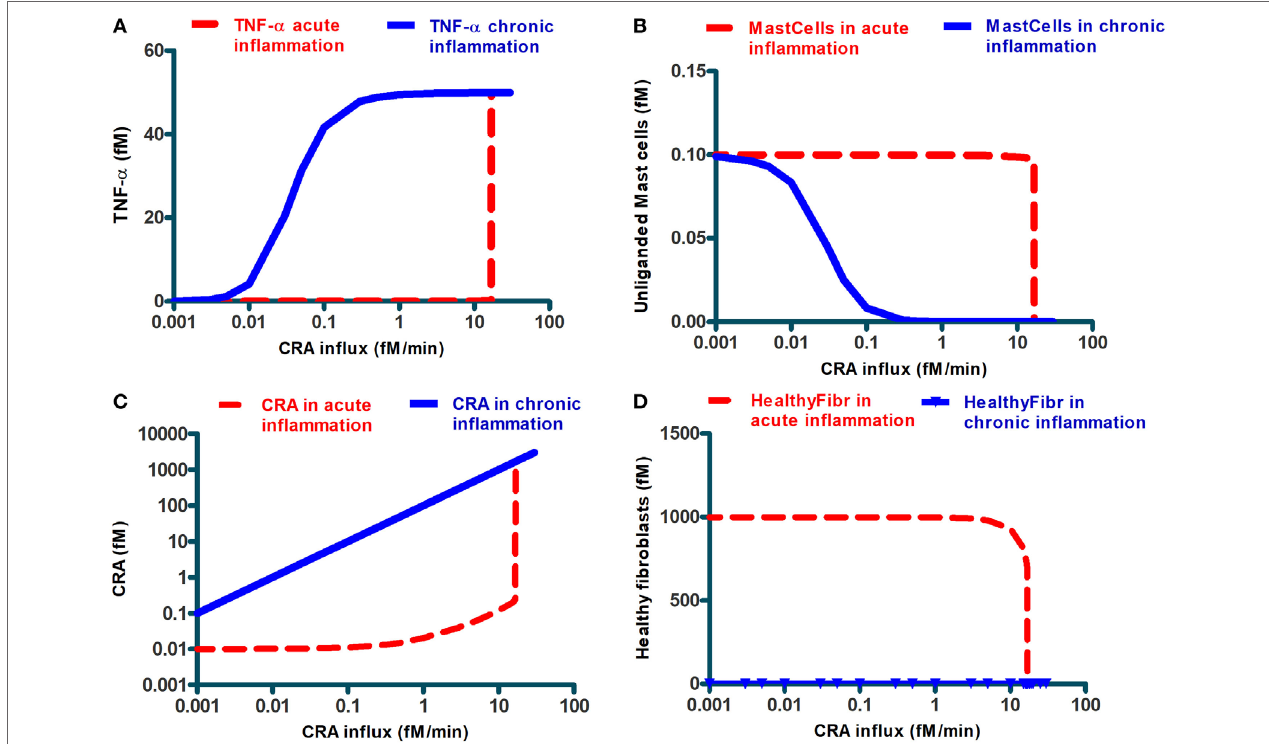
FigUre 4 | Steady-state levels of various network components at the final steady state achieved when starting from an initial state at very low CRA influx (dashed lines; we call this “acute inflammation”) or starting from an initial state at very high CRA influx (full lines; we call this “chronic inflammation”). The former cases were calculated by starting at a steady state at 0.001 fM/min CRA influx and then increasing that influx to the level indicated on the abscissa. The latter cases were computed by starting at the steady state achieved for 30.0 fM/min CRA influx and by then reducing the CRA influx to the rate indicated on the abscissa (where steady-state concentrations were below 10 –9 , which was the resolution of COPASI computation, MMP7 and MMP8, healthy and dying fibroblasts, we reset them to 10 –9 fM). The components are, as indicated, (a) TNF- α , (B) unliganded mast cells, (c) CRA, and (D) healthy fibroblasts. The symbols in (D) refer to the CRA values for which actual calculations were carried out. In all figures, lines in between were obtained by linear interpolation between calculated